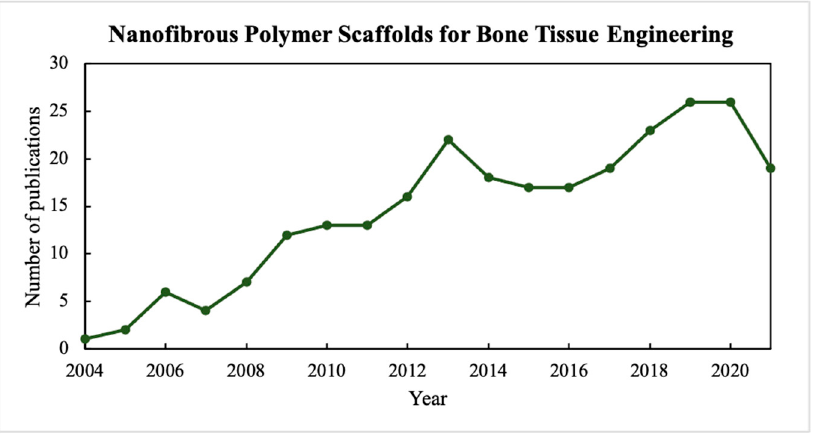
Figure 1. The number of published papers on nanofibrous polymer scaffolds for bone tissue engi-